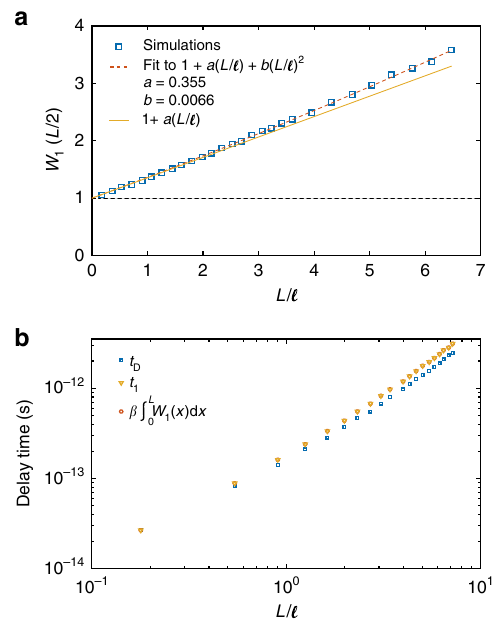
Fig. 5 Scaling of W 1 ( L /2) and the delay times. a The scaling of W 1 ( L /2) (blue squares) is fi t by a parabolic function 1 + a ( L / ℓ ) + b ( L / ℓ ) 2 . The fi t gives a = 0.355 and b = 0.0066 (red dashed curve). The linear coef fi cient a can be calculated using diffusion theory, while the quadratic term re fl ects enhanced delay due to incipient localization. The sum of the constant term of unity (black dashed horizontal line) and the linear term of a ( L / ℓ ) is shown as the yellow solid line. b The delay time of the fully transmitting eigenchannel obtained from the composite phase derivative of the eigenchannel with respect to the frequency shift 38 is shown as the triangles in Fig. 5b. The integral of W 1 ( x ) multiplied by the proportionality constant β is shown as the red circles in the log-log plot of Fig. 5b. The overlap of the two plots shows that the integral W 1 ( x ) is proportonal to the delay time of the fully transmitting eigenchannel (Supplementary Note 4). The scaling of t D , shown as the blue squares, is similar to the scaling of t